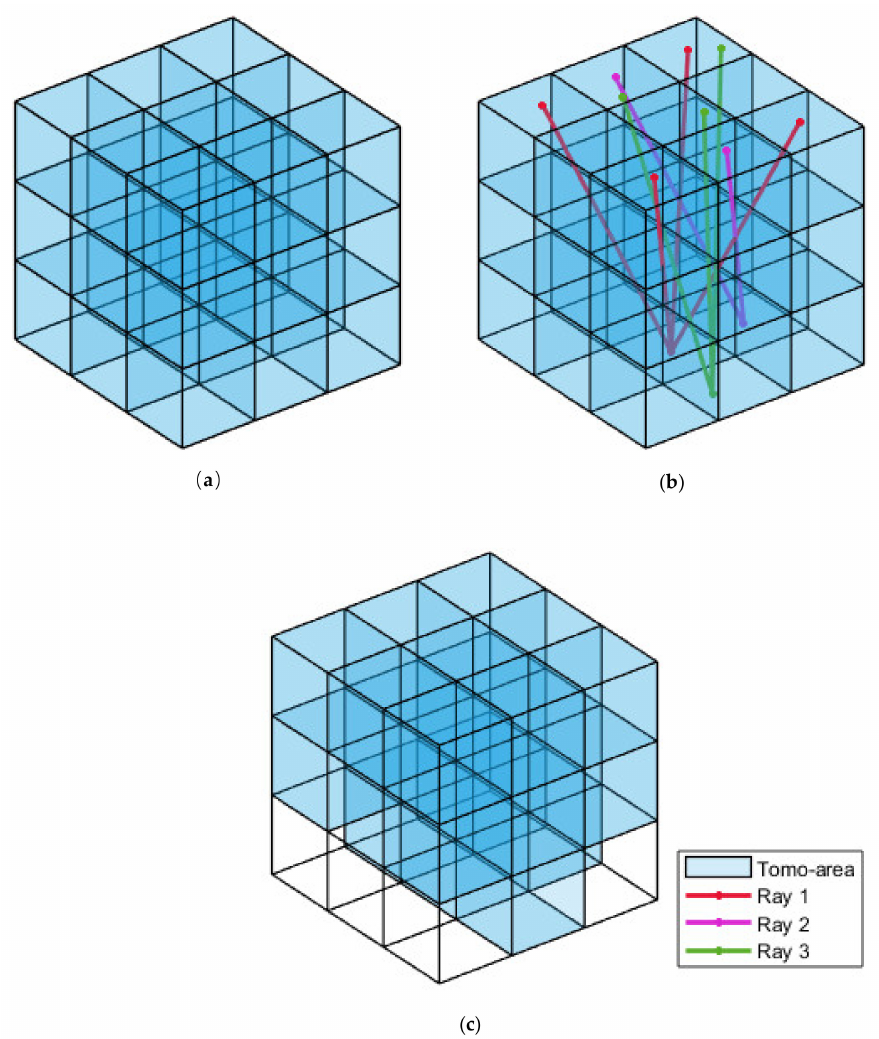
Figure 3. Voxel optimization process. ( a ) All voxels in the tomographic zone. ( b ) All voxels and visual rays from three sites. ( c ) Voxels through which rays pass.